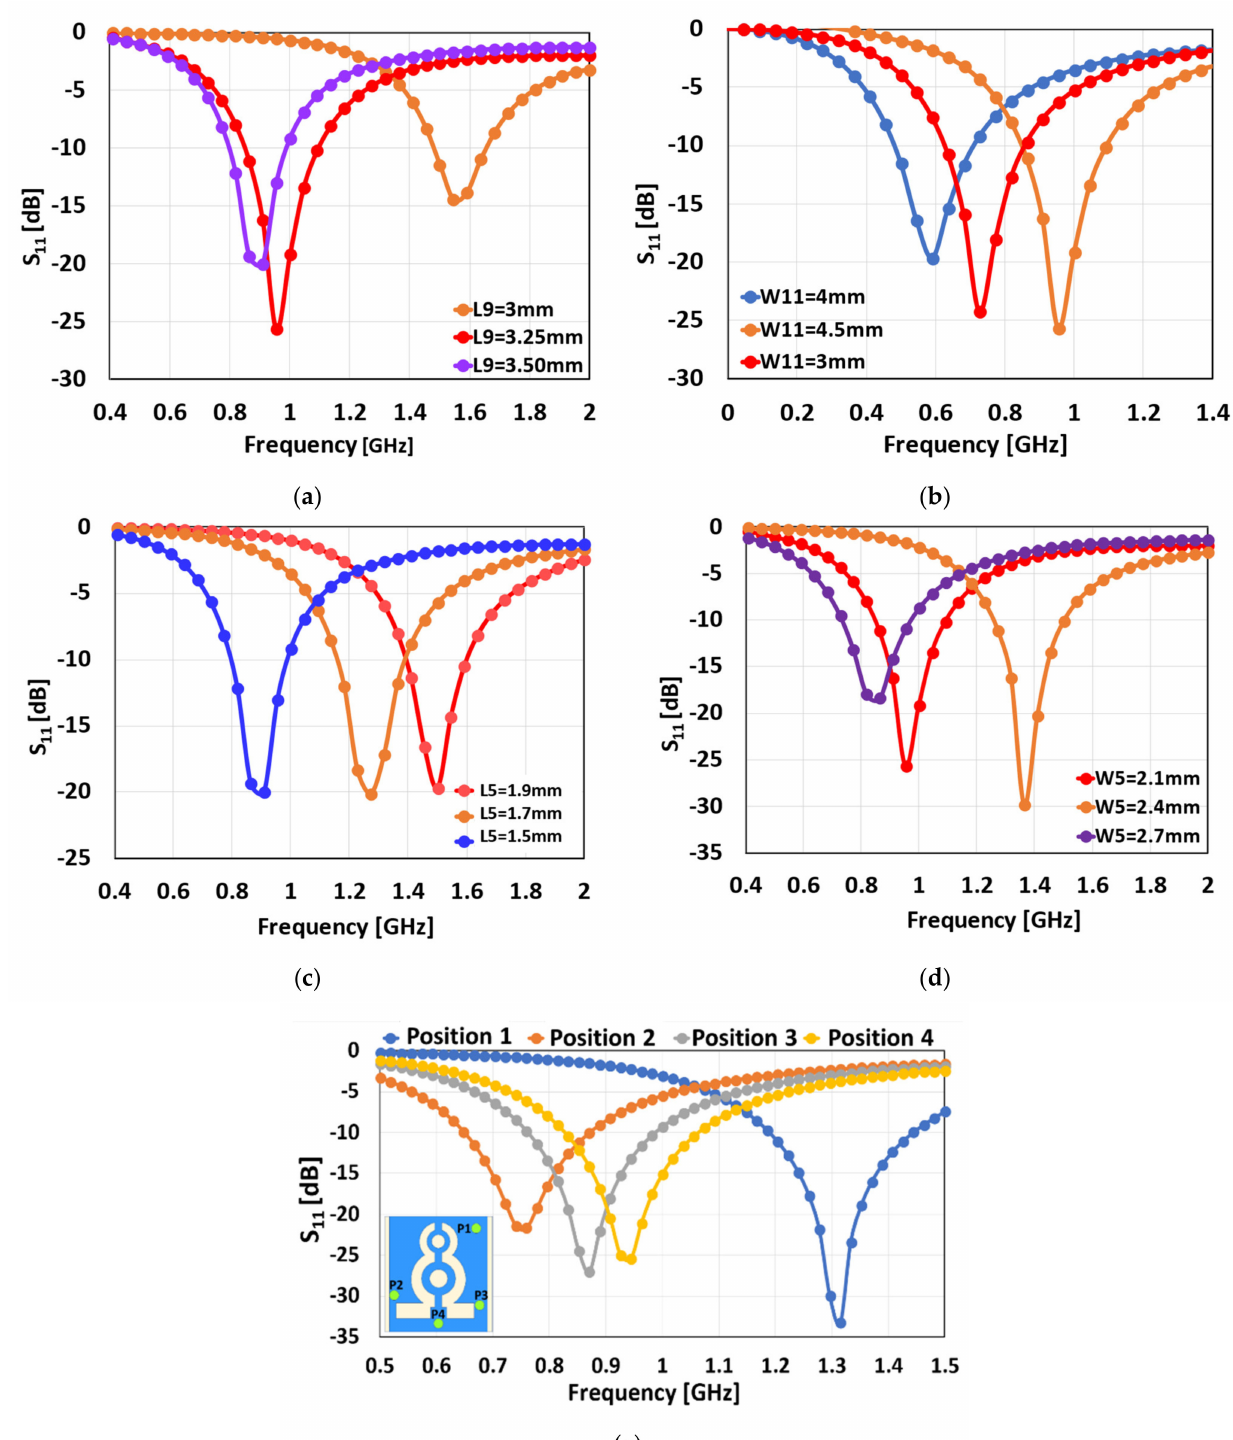
Figure 7. Parametric optimization of the design; ( a ) change in ‘L 9 ’, ( b ) change in ‘W 11 ’, ( c ) change in ‘L 5 ’, ( d ) deviation in ‘W 5 ’, and ( e ) shifting the location of the